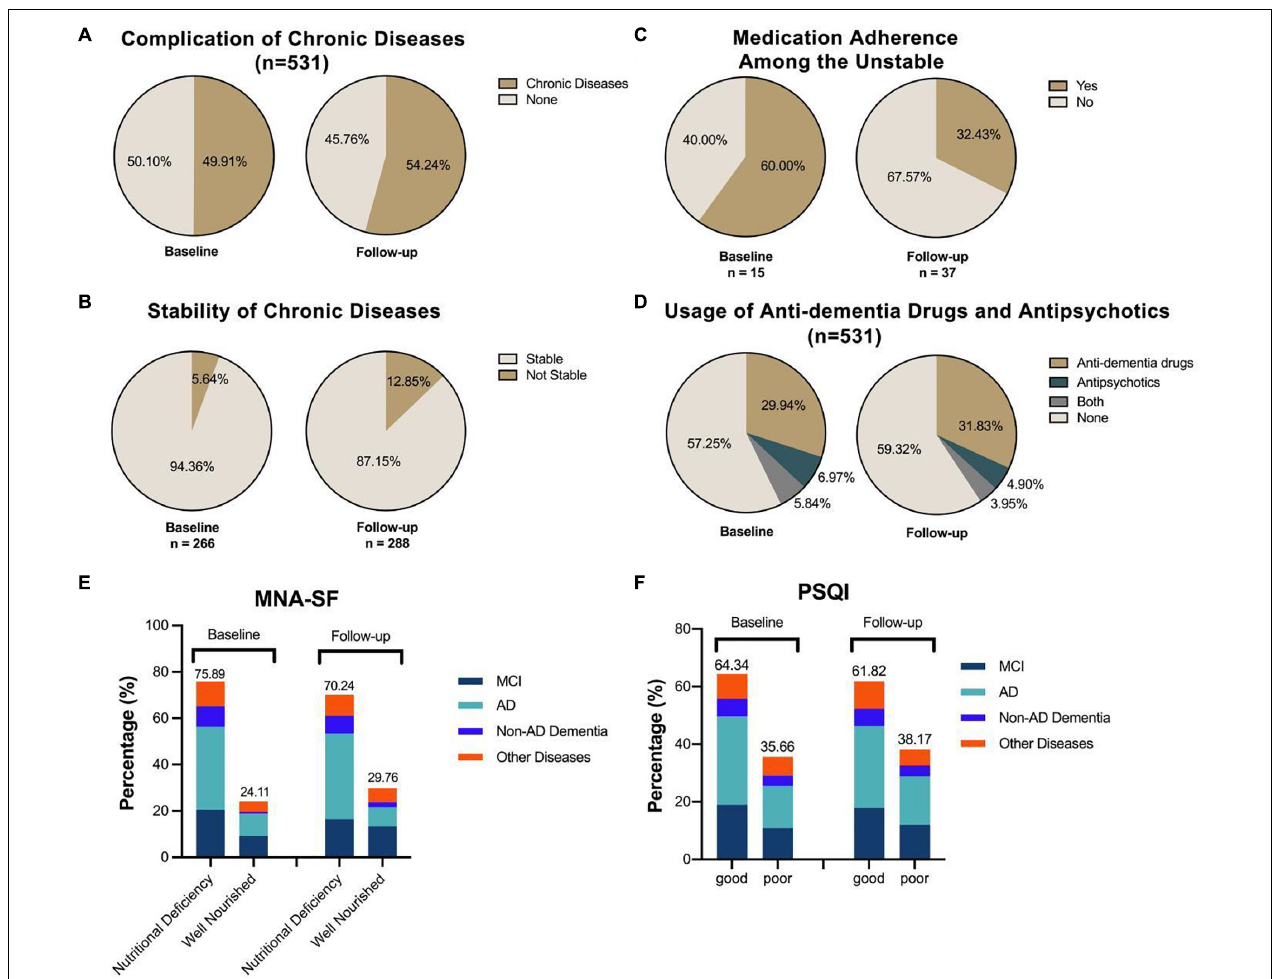
FIGURE 1 | The fluctuation of chronic disease control, nutritional status, and sleep quality. The percentage of patients enrolled having chronic diseases rose nearly 4% from the baseline level (A) , and the instability of such disease also increased by around 7% (B) . Among the patients who claimed the unstable control of their chronic disease, the rate of medication adherence dropped from 60.00 to 32.43% (C) . The percentage of taking anti-dementia and/or antipsychotics was rising by around 7%, reaching nearly half of the subjects receiving corresponding treatment (D) . For nutritional status (E) , the at-risk-of-malnutrition and malnutrition groups were defined as nutritional deficiency. The results for the Pittsburgh Sleep Quality Index (PSQI)-based binary classification of sleep quality revealed no significant difference between these two investigations (F)